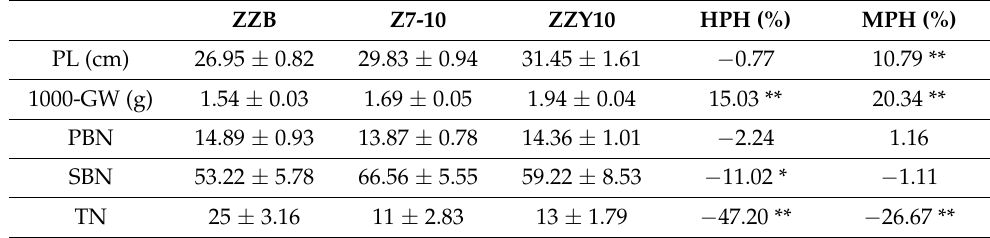
Table 1. MPH and HPH of panicle traits at the heading